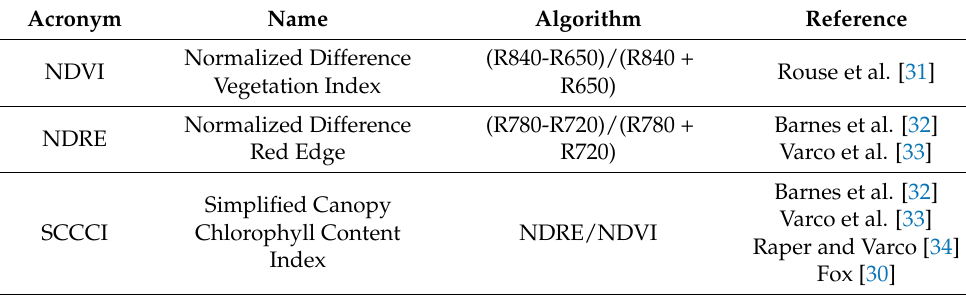
Table 4. Vegetation indices used in the study table adapted from Fox